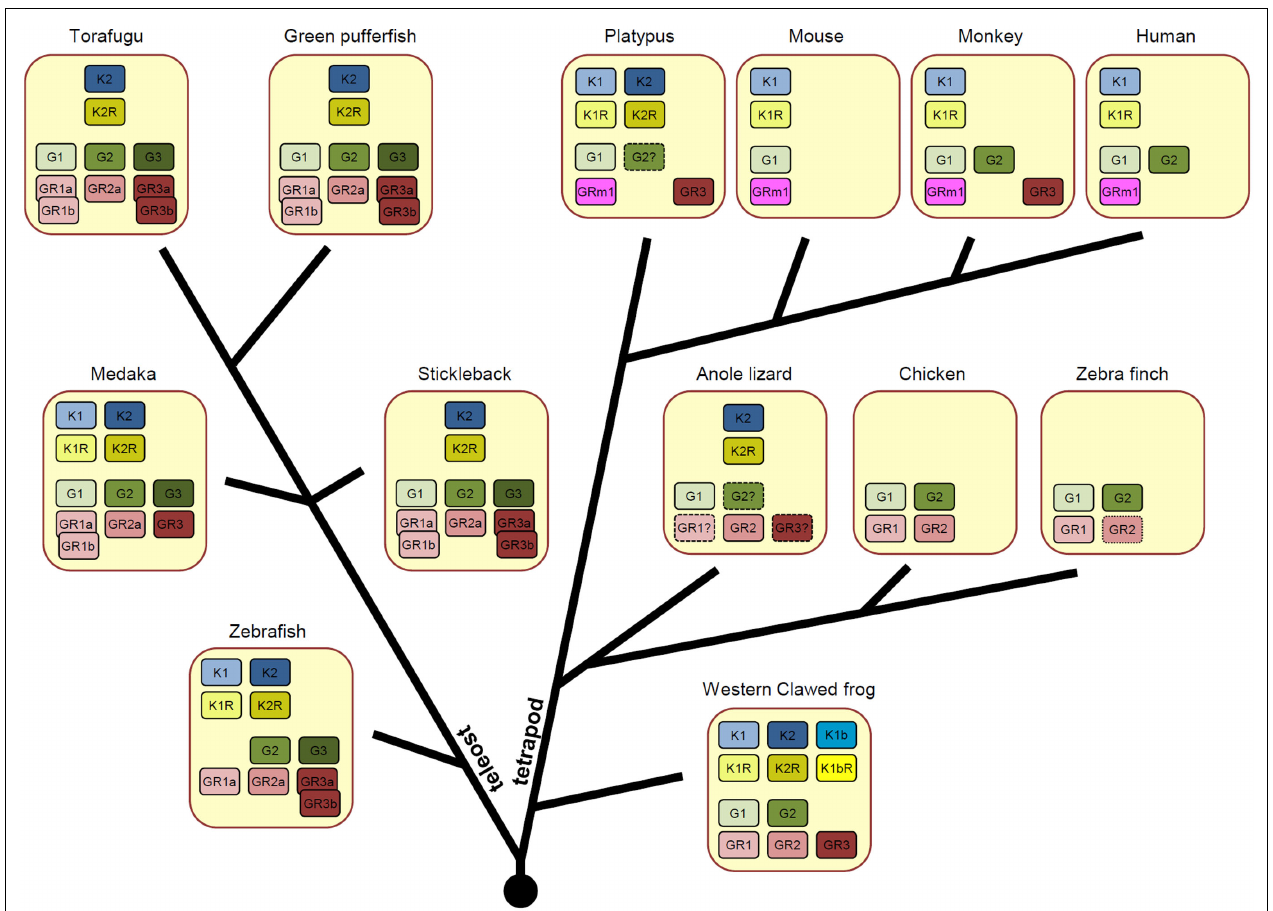
FIGURE 2 |Varied number of KiSS (K), KiSSR (KR), GnRH (G), and GnRHR (GR) genes across vertebrate species. Orthologous genes were categorized in our recent article (Kim et al., 2011) and are presented with the same colors. For teleost fish, the GnRHR genes produced by teleost-specific genome duplication are